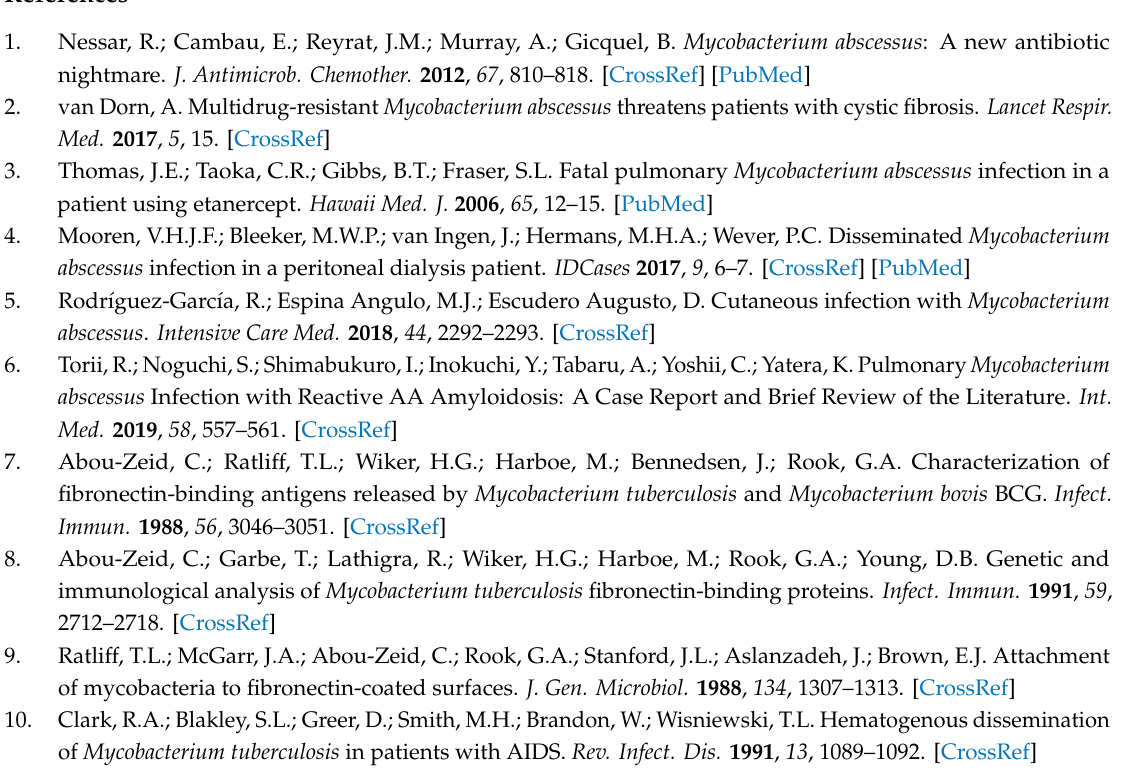
Figure S1: Ag85-Fn force interactions in M. abscessus S